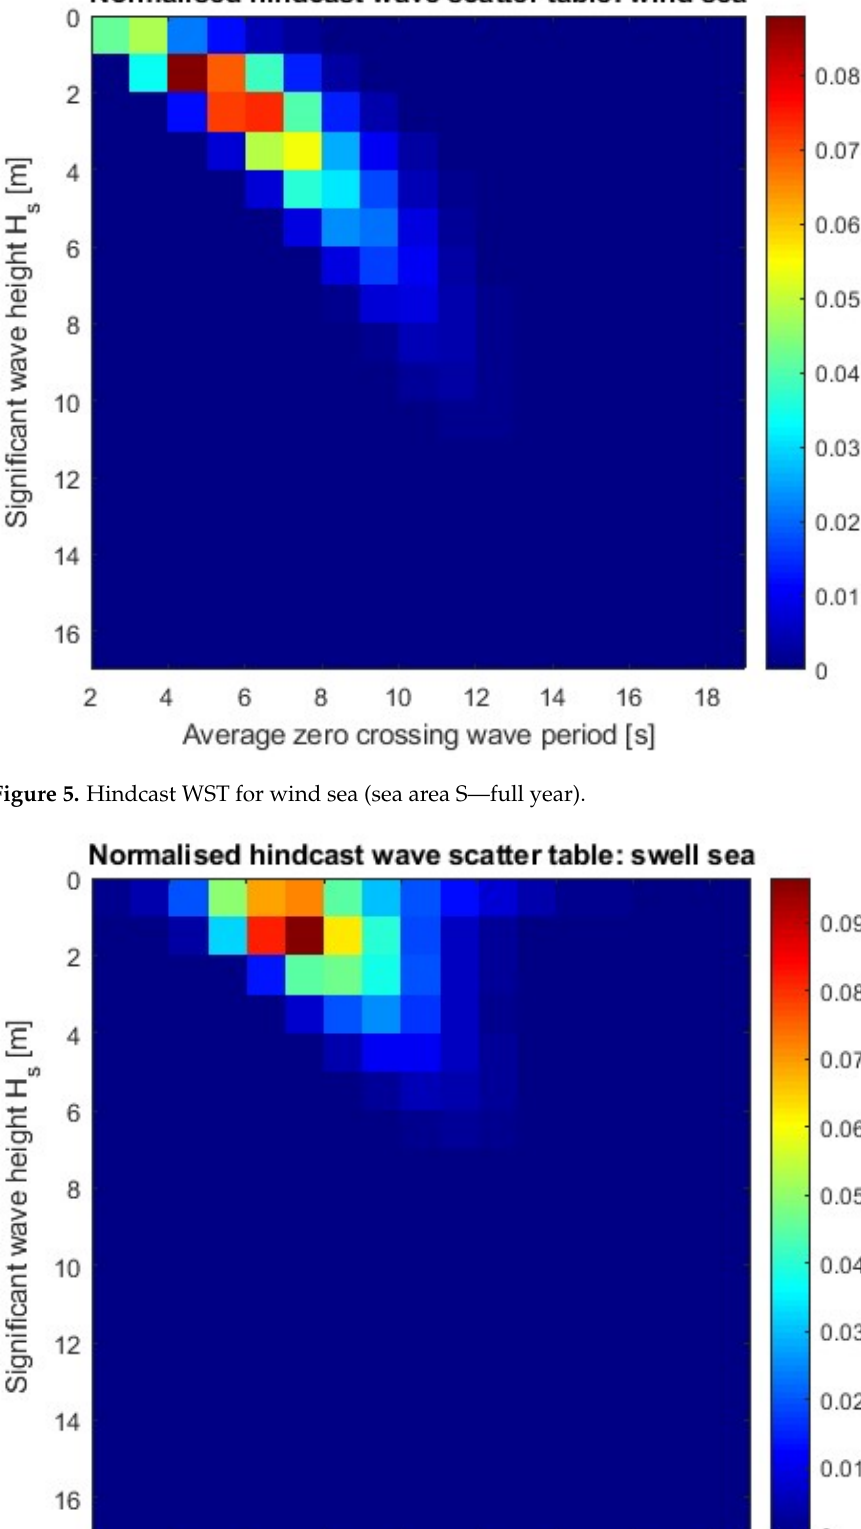
Figure 4. Hindcast WST for mean sea (sea area S—full year).